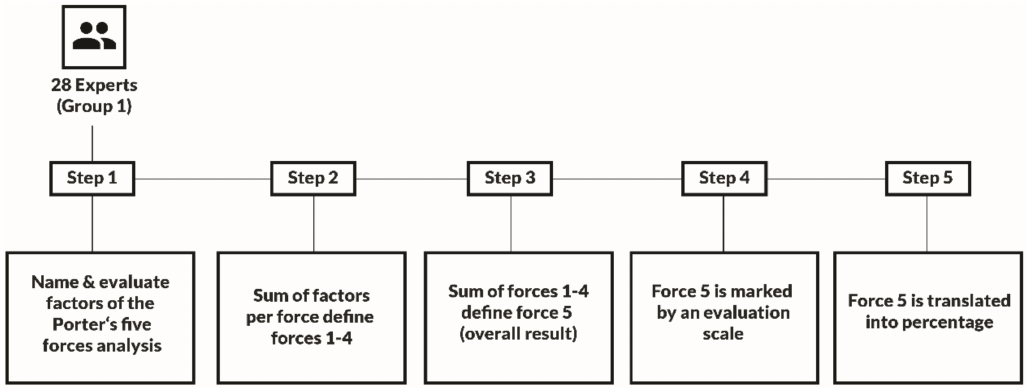
Figure 3. Summary of various steps for methodology applied (Porters’ five forces analysis).